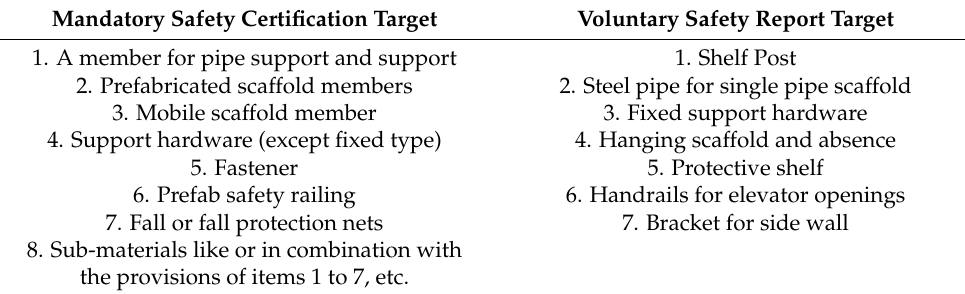
Table 4. Subjects for safety certification and autonomous safety verification.